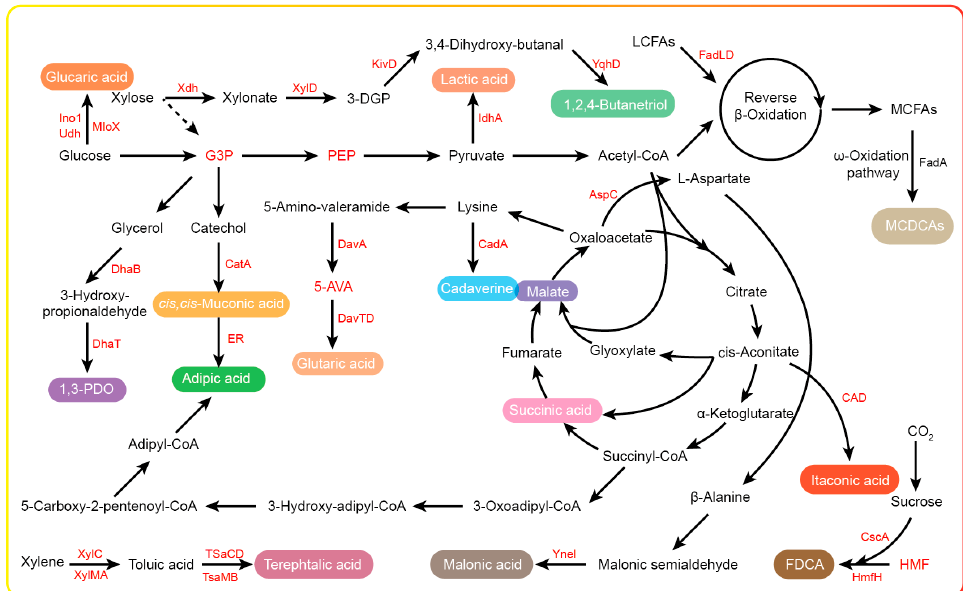
Figure 1. Overall metabolic pathways for the production of biobased-monomers from substrates.